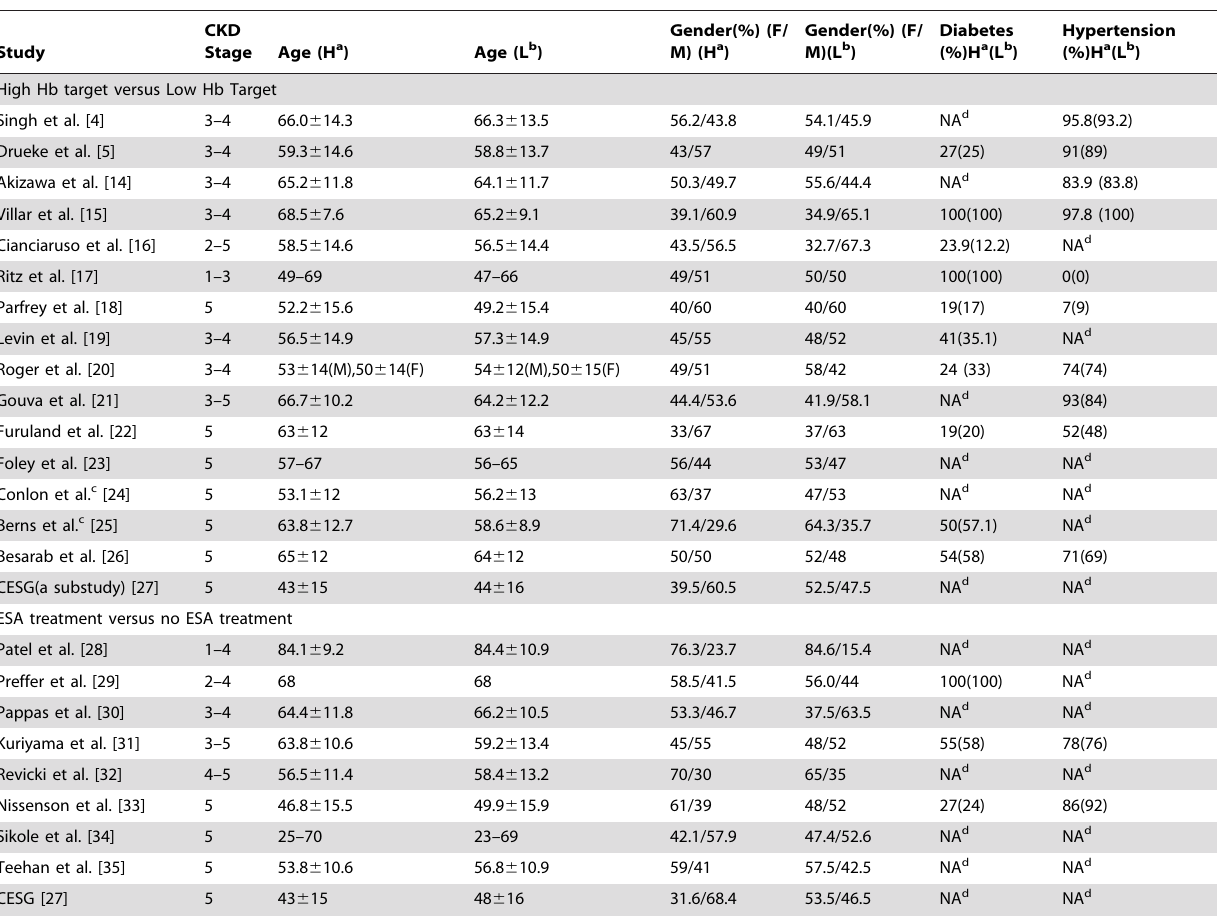
Table 1. Baseline Characteristics of the Participants.